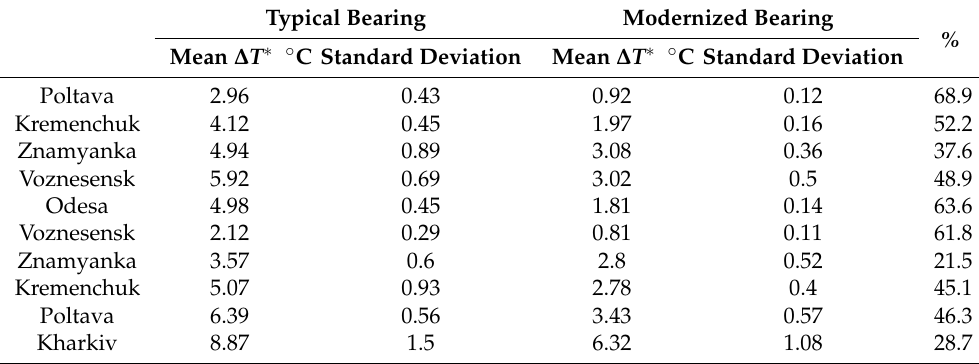
Table 2. The temperature gradient in the rolling bearings. Generalized experimental